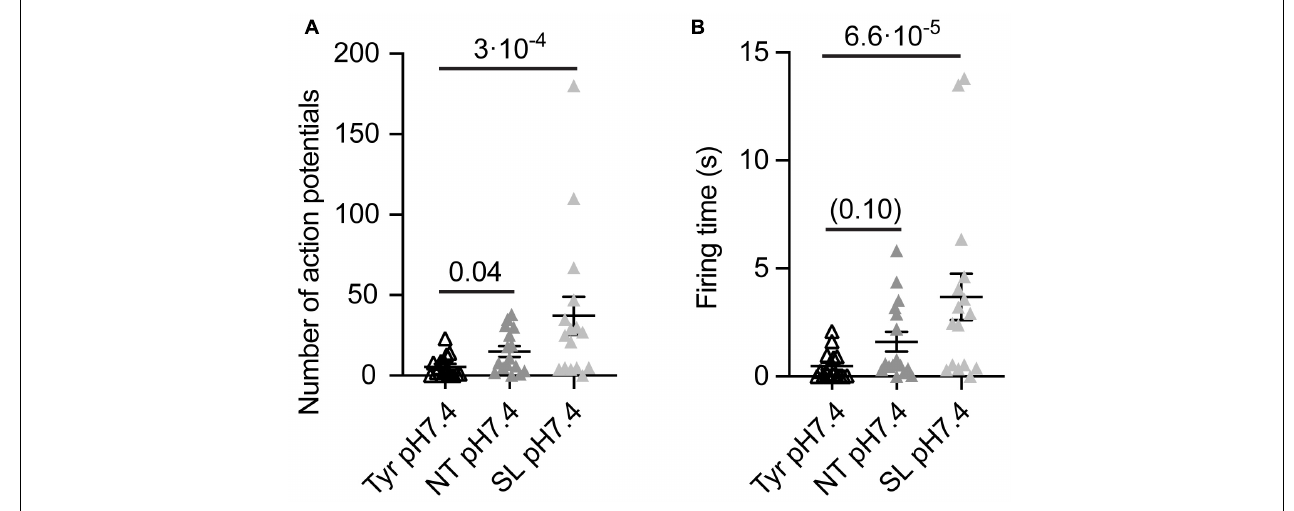
FIGURE 4 | Analysis of AP number and firing time as a function of ion composition at pH7.4 from WT cortical neurons. The data were obtained from current-clamp experiments with cortical neurons as described in the legend to Figure 2 . Note that in these experiments there was a signaling activity even at Tyr-pH7.4, probably due to a higher neuron density than in the experiments of Figures 1–3 . The solutions were changed with a rapid solution change system from Tyr-pH7.4 to Tyr-pH7.4, NT-pH7.4 or SL-pH7.4 in each of the neurons tested to obtain a direct comparison between the three conditions of the number of APs (A) and the FT ( B , n = 16). The statistical significance of the differences between mean values was tested with the Friedman test, followed by Dunn’s multiple comparisons